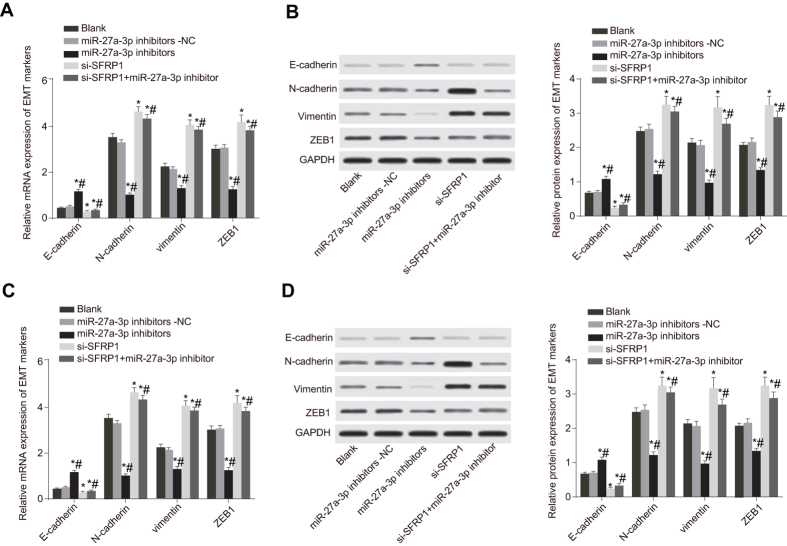
The mRNA and protein expression of EMT phenotypic markers in OSCSCs in the miR-27a-3p inhibitors, miR-27a-3p inhibitors-NC, si-SFRP1, si-SFRP1 + miR-27a-3p inhibitors and blank groups after the down-regulation of miR-27a-3p.(A) The mRNA expression of E-cadherin, N-cadherin, vimentin and ZEB1 in SCC-9 OSCSCs in the five groups as detected by qRT-PCR; (B), The protein expression of E-cadherin, N-cadherin, vimentin and ZEB1 in SCC-9 OSCSCs in the five groups as detected by Western blotting. (C) The mRNA expression of E-cadherin, N-cadherin, vimentin and ZEB1 in Tca8113 OSCSCs in the five groups as detected by qRT-PCR. (D) The protein expression of E-cadherin, N-cadherin, vimentin and ZEB1 in Tca8113 OSCSCs in the five groups as detected by Western blotting; *represents P < 0.05 comparisons with the blank and miR-27a-3p inhibitors-NC groups. #Represents P < 0.05 compared with the si-SFRP1 group;. EMT, epithelial-mesenchymal transition; OSCSCs, oral squamous carcinoma stem cells; ZEB1, zinc finger e-box binding homeobox 1; qRT-PCR, quantitative real-time polymerase chain reaction.